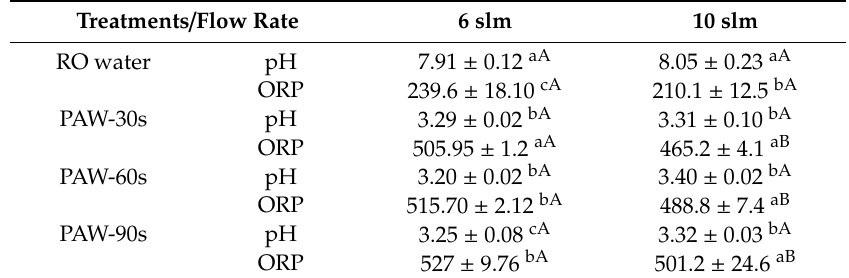
Table 5. The values of pH and oxidative-reduction potential (ORP) of 1000 mL PAW generated by two plasma jets at di ff erent treatment times and flow